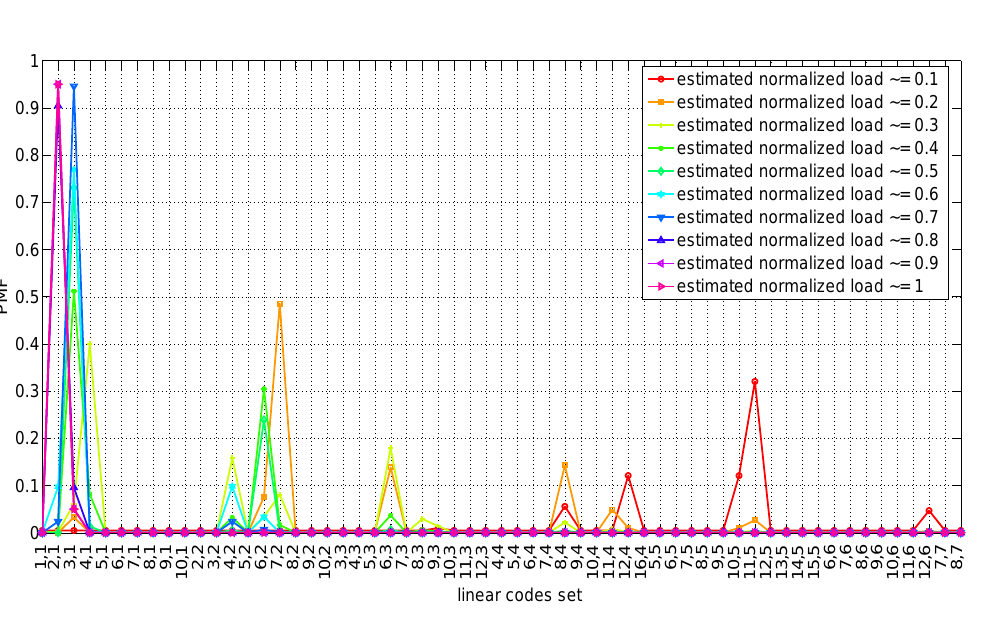
Figure 11. PMF for LC algorithm at different load levels for increasing G , linear code set C as in table ??